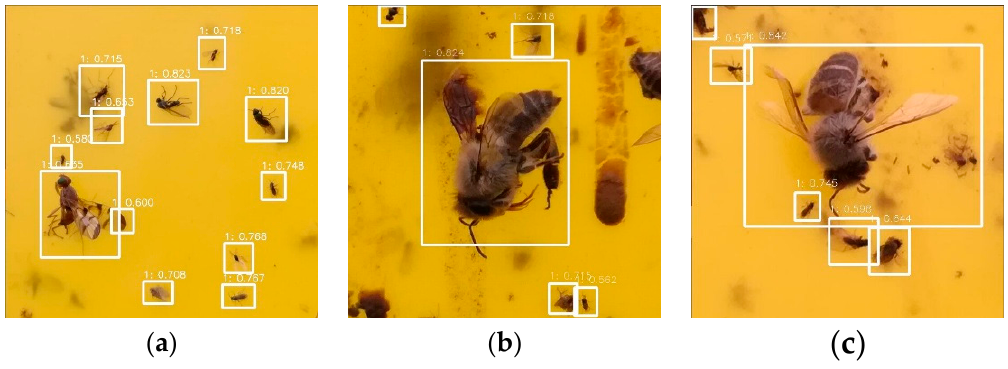
Figure 10. Detection instance of flying insects based on YOLO method. ( a ) Instance 1; ( b ) Instance 2; ( c ) Instance 3.